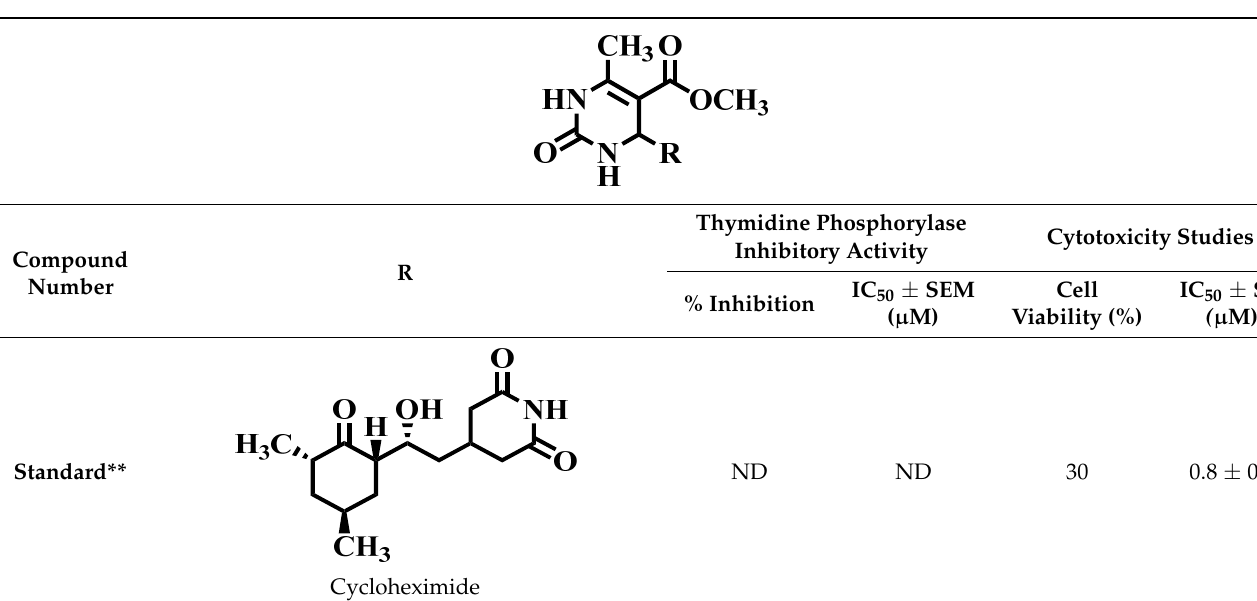
Table 1. Thymidine phosphorylase (TP) inhibitory activity of dihydropyrimidone ( 1 – 40 ). Table 1. Cont.